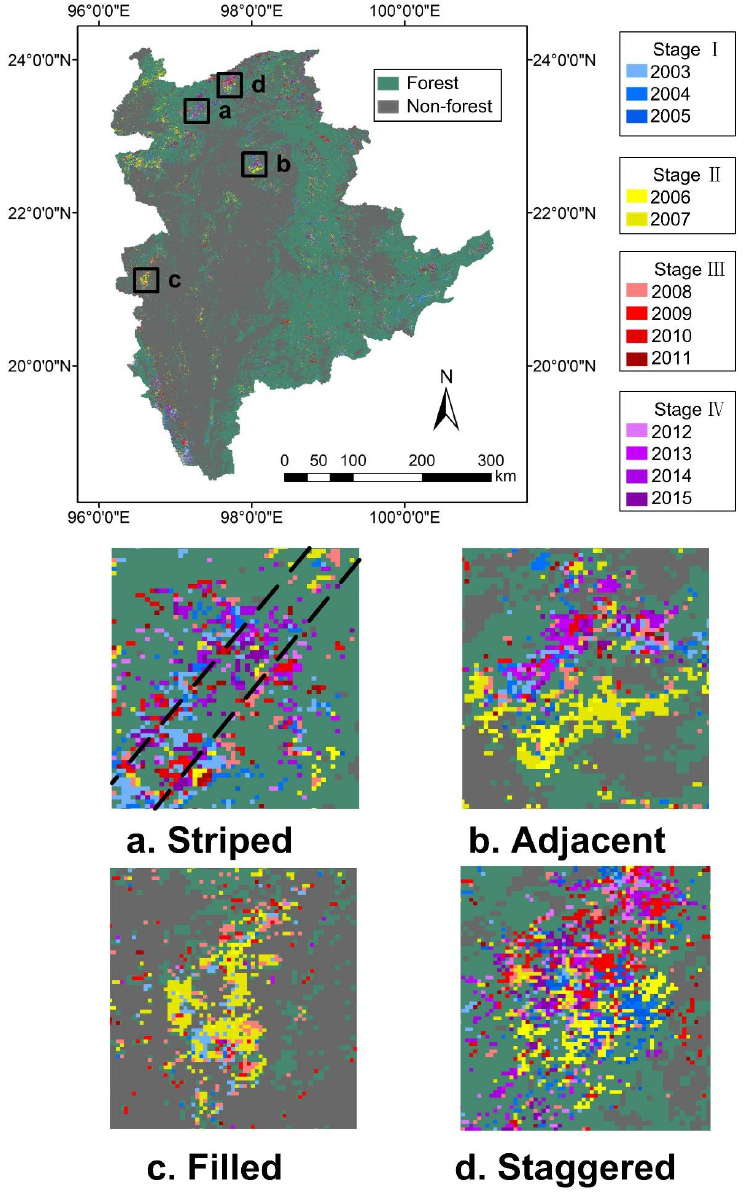
Figure 4. Spatial patterns of deforestation from 2003 to 2015 in upland Myanmar: ( a ) Stage I; ( b ) Stage II; ( c ) Stage III; ( d ) Stage IV. The four stages are the main deforestation stages in the study area in the